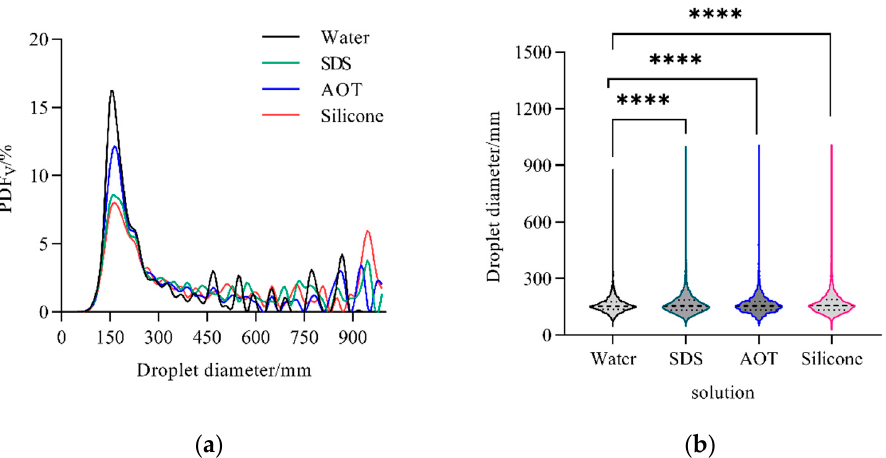
Figure 9. ( a ) Curve of probability volume density function (PDF V ). ( b ) Violin plot of drop size for the AIXR nozzle with different solutions. “****” indicates significance at p ≤ 0.0001.